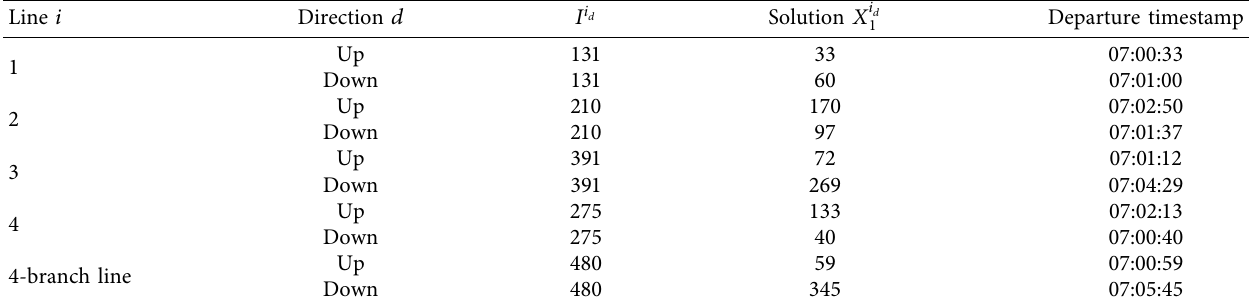
Table 7: Optimal solution for the train network (peak